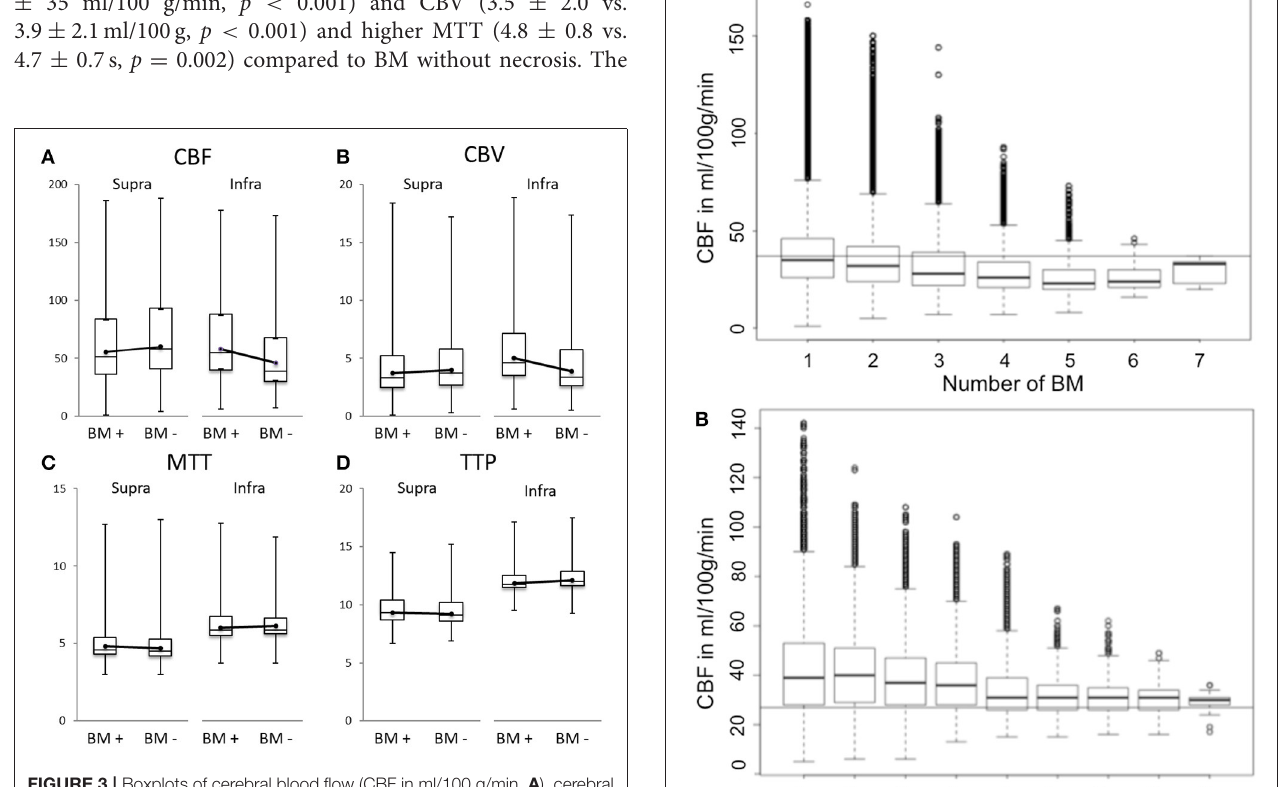
FIGURE 3 | Boxplots of cerebral blood flow (CBF in ml/100 g/min, A ), cerebral blood volume (CBV in ml/100g, B ), mean transit time (MTT in s, C ), and time to peak (TTP in s, D ) of the supra- (left side of each panel) and infratentorial area (right side), always for the brain metastases (BM pos = BM + ) and their corresponding area without any BM (BM neg = BM –). The dots represent the mean. For better comparability between BM pos and BM neg , they are connected by a line.